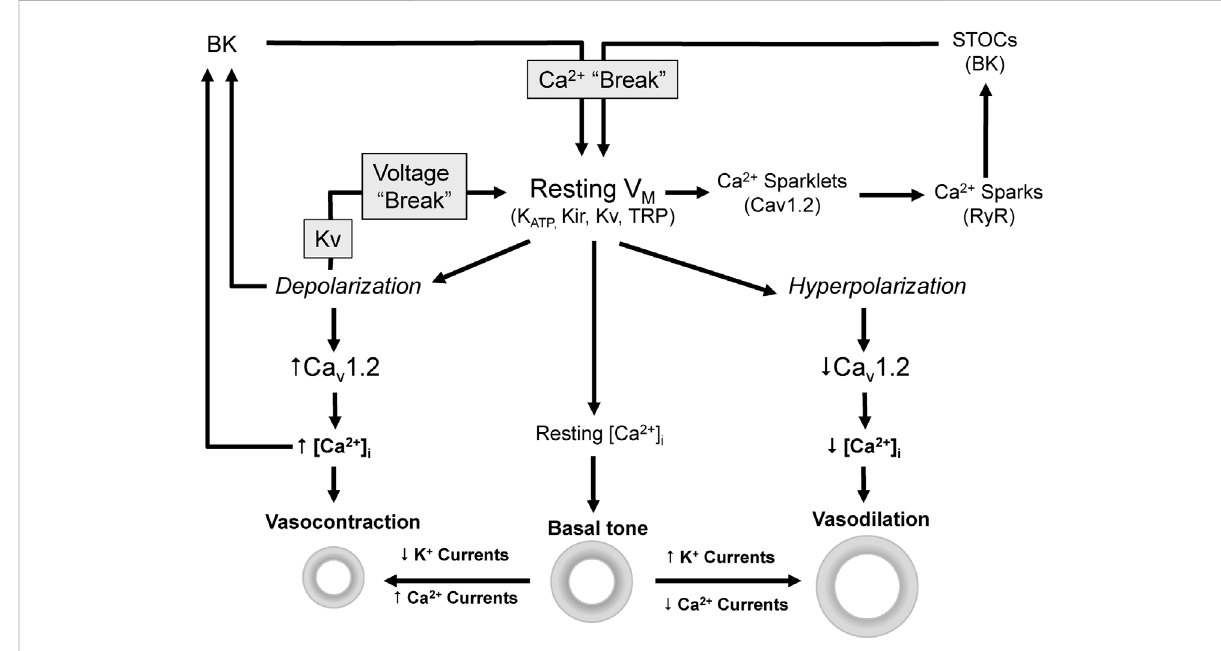
FIGURE 1 Ion channels modulate V M [Ca 2+ ] i and vascular tone. Vascular tone depends on [Ca 2+ ] i which is mainly determined by the V M dependent activity of Cav1.2. Depolarization activates Cav1.2, increases Ca 2+ in fl ux and [Ca 2+ ] i leading to vasoconstriction. On the contrary hyperpolarization leads to closure of Cav1.2 channels and ultimately to